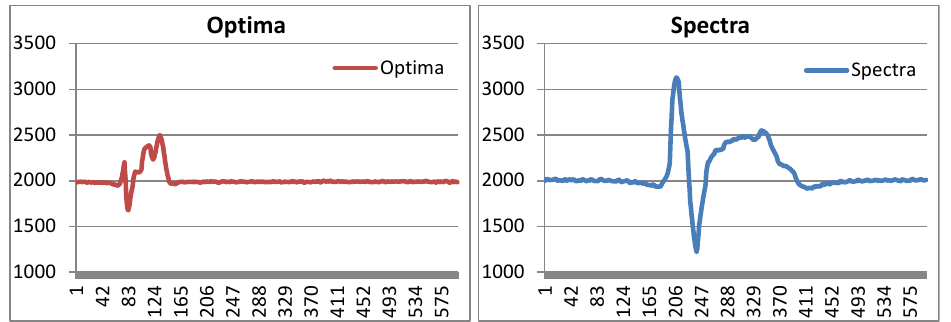
Figure 8. Refined data, D(k), gathered by prototype